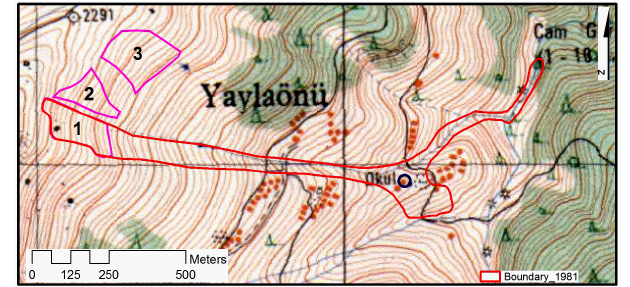
Fig. 7. Outlines of the 1981 avalanche event and potential release zones (damaged school indicated in blue circle, see Fig.